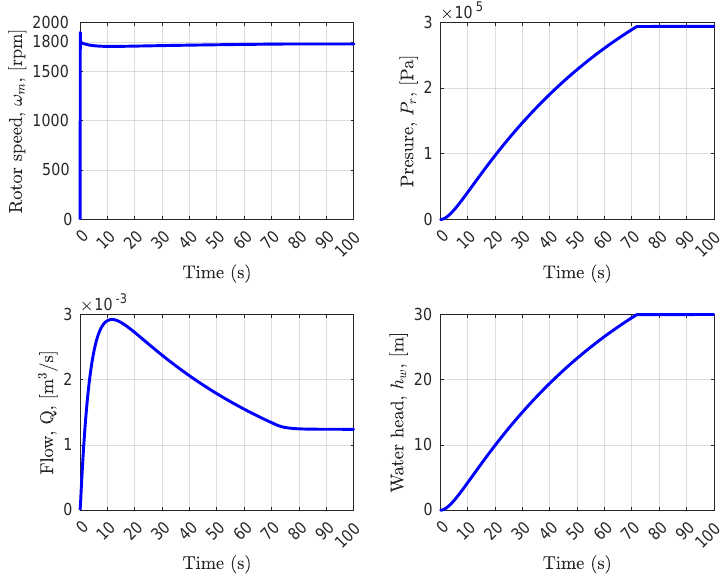
Figure 3. First scenario: operation of the hydro pump system, i.e., s = 0. The initial conditions are Q ( 0 ) = 0.0 ( m 3 / s ) , P r ( 0 ) = 0.0 ( Pa ) , and h w = 0.0 ( m ) , which is the minimum capacity of the penstock and the upper reservoir